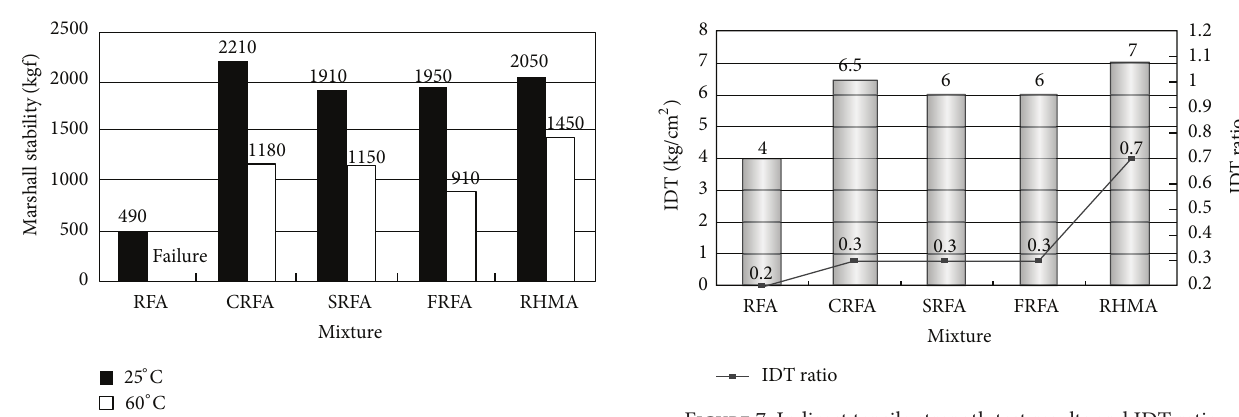
Figure 6: Marshall stability test results at 25 ∘ C and 60 ∘ C.